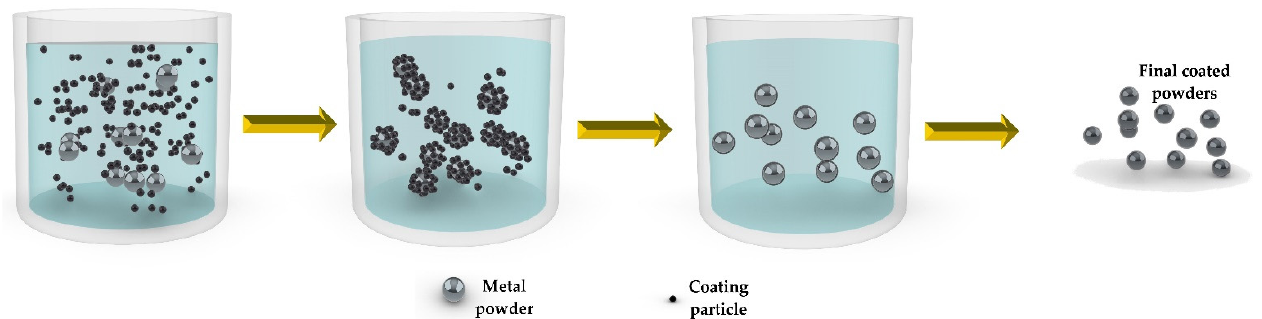
Figure 3. Schematic diagram of coating process involving solution for coating powders, the objects in figures are not in scale.